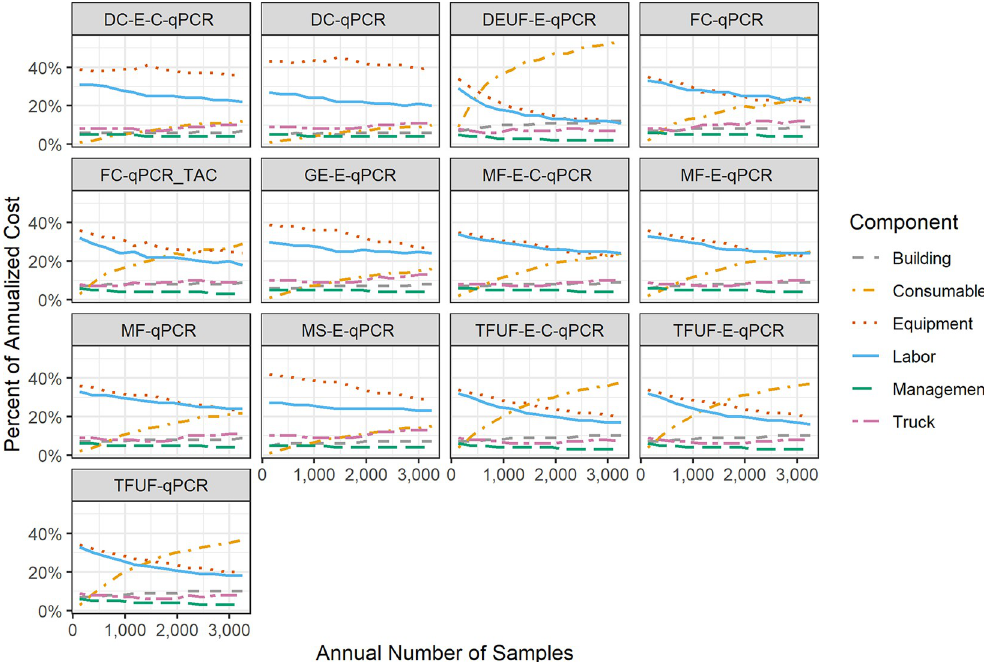
Fig 3. Breakdown of annualized costs as a percentage of the total for each protocol. Values are the median of the percentage calculations from 1,000 simulation trials, so the component categories may not sum to 100%. Non-smooth trajectories are indicative of step-changes in cost, for example the purchase of an additional piece of equipment or the need to hire a staff member. Assumes bi-weekly sampling and that the increase in number of samples is due to incremental sampling sites. DC, differential centrifugation; DEUF, dead end ultrafiltration; FC, filter cartridge; GE, grab enrichment; MF, membrane filtration; MS, Moore swab; TFUF, tangential flow ultrafiltration.